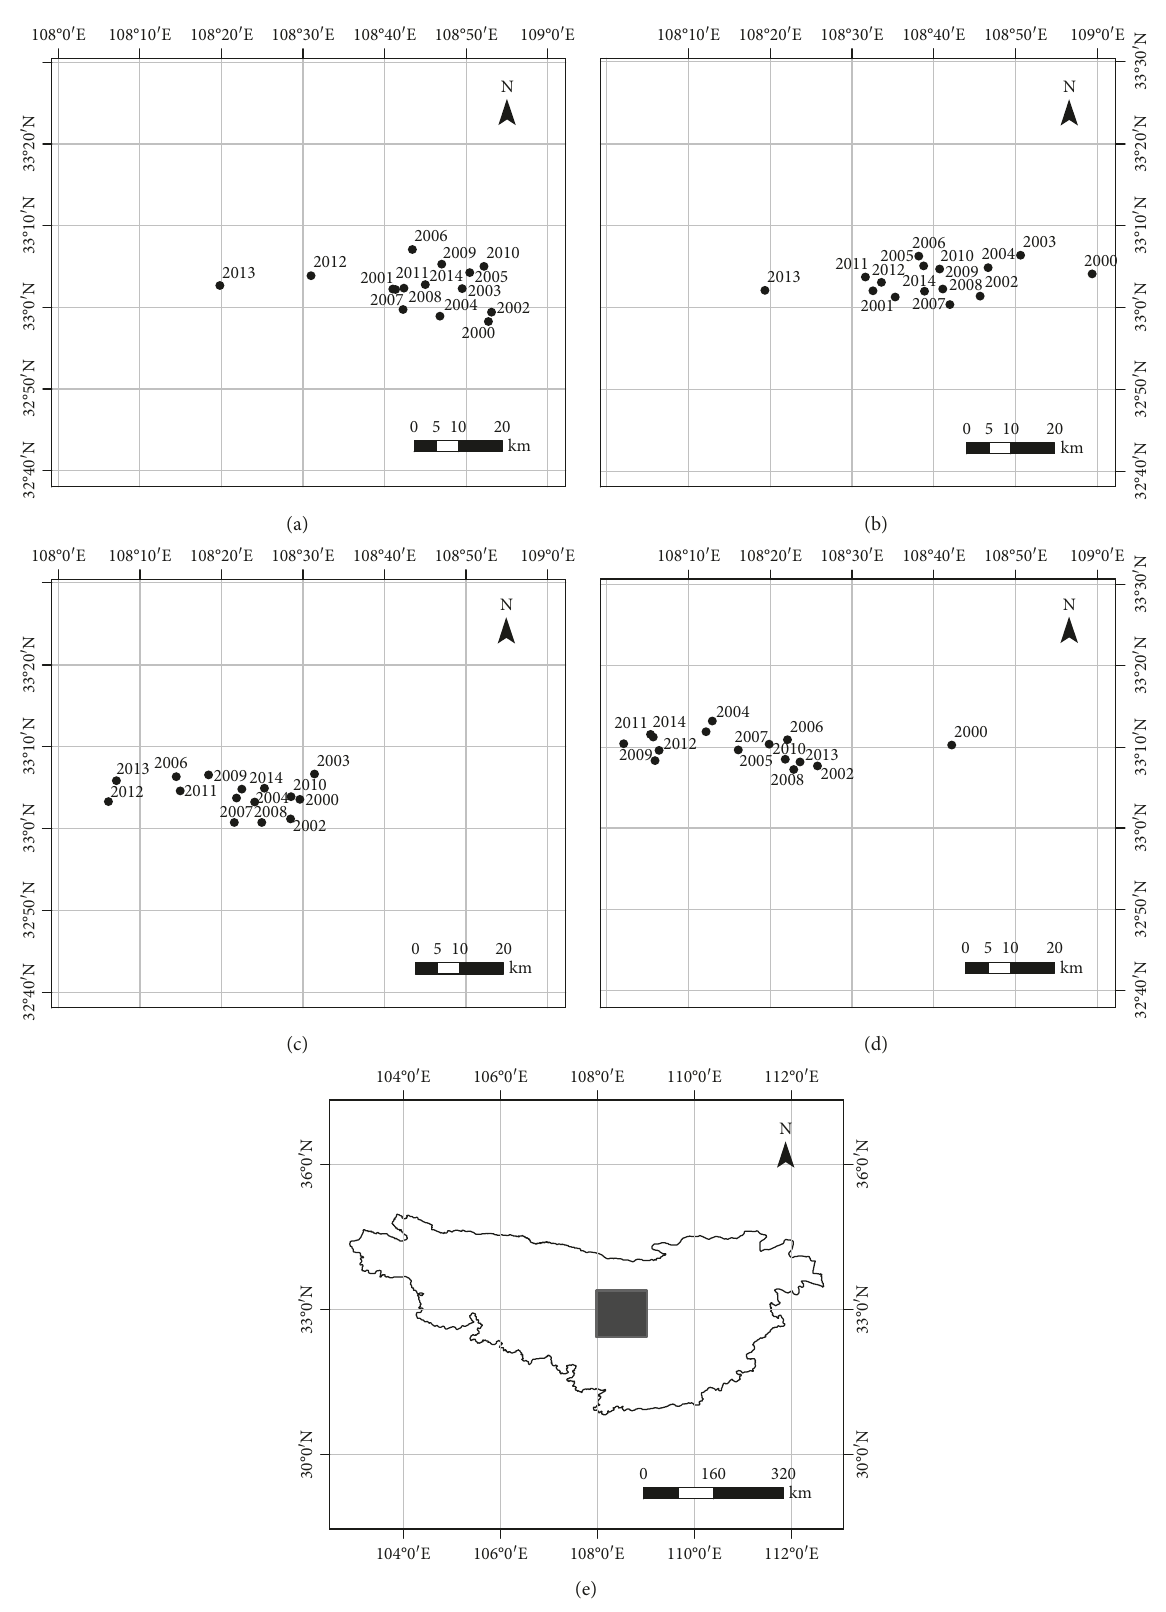
Figure 8: The precipitation centroids over the Qinling-Daba Mountains during 2000 to 2014 of (a) rain gauge, (b) ERA-Interim, (c) JRA-55, and (d) NCEP/NCAR-1, and (e) the black box represents the data range in